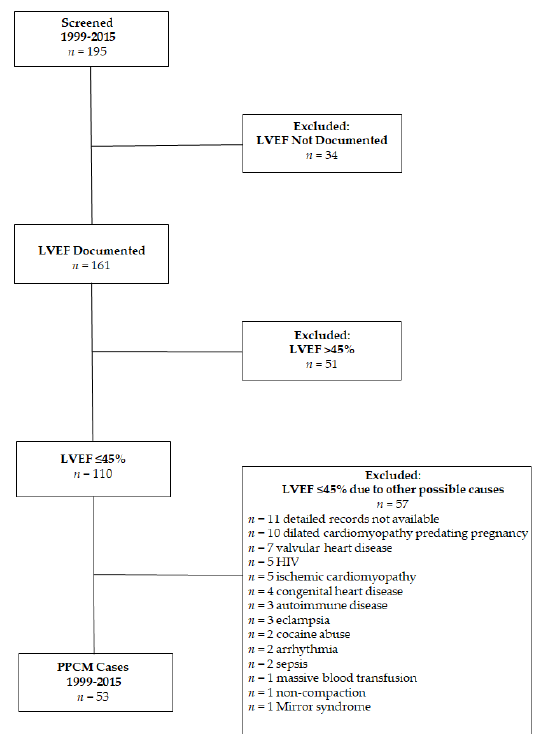
Figure 1. Flowchart of inclusion and exclusion of peripartum cardiomyopathy cases. HIV = human immunodeficiency virus; LVEF = left ventricular ejection fraction; Mirror syndrome = preeclampsia, fetal hydrops, and parvovirus infection; PPCM = peripartum cardiomyopathy.